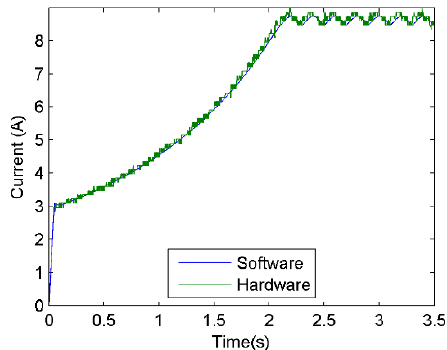
Figure 26. Voltage response of the converter with the MPPT controller emulator.